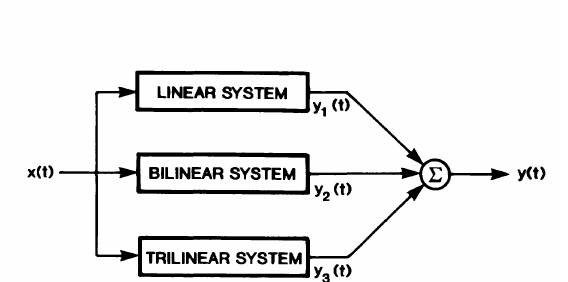
FIGURE 4 Third-order nonlinear system input/out put